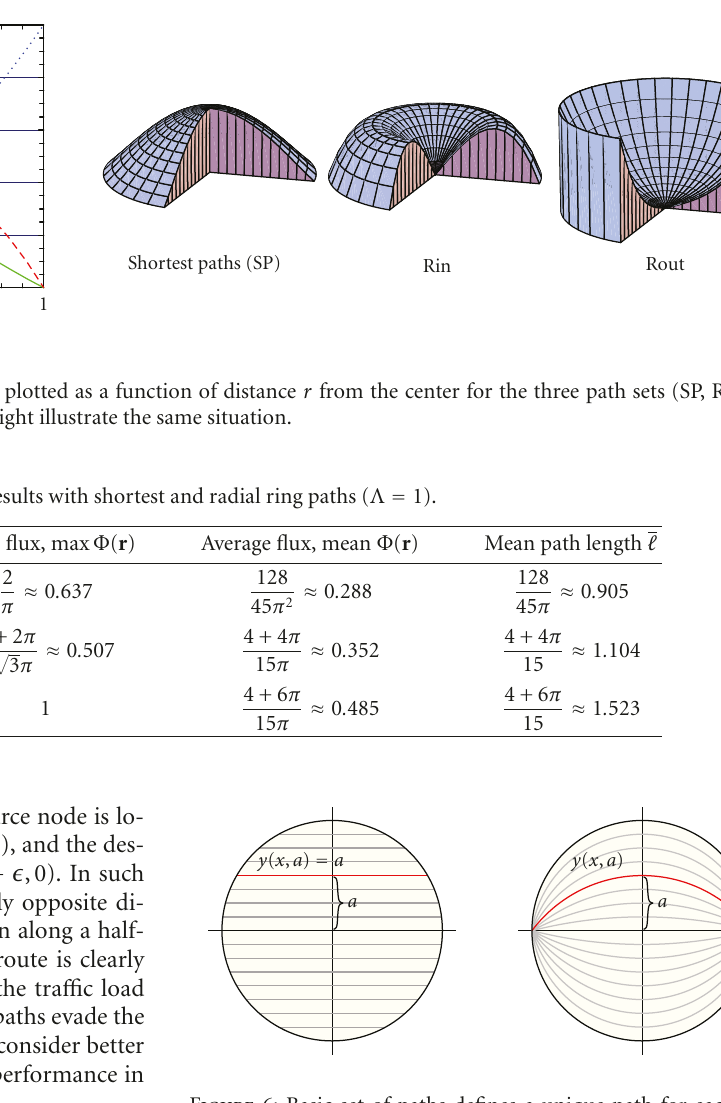
Figure 6: Basic set of paths defines a unique path for each value of parameter a . Paths on the left figure correspond to the short- est paths (i.e., straight line segments) and paths on the right corre- spond to the circular paths (see Example